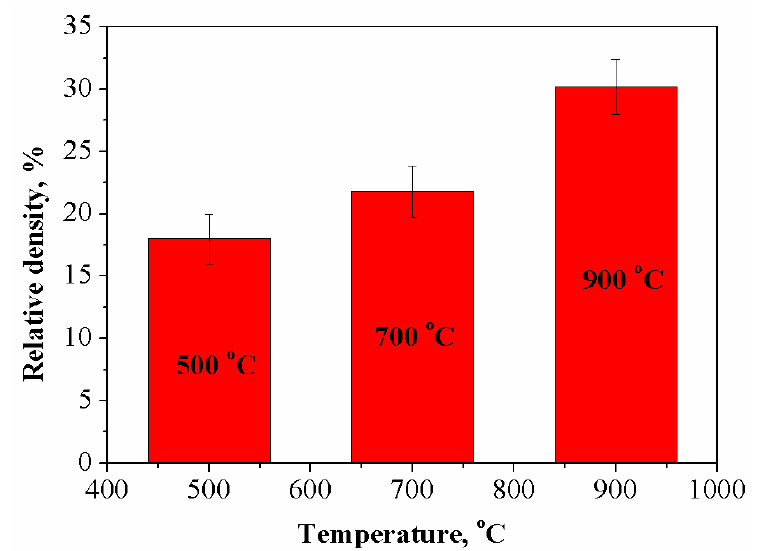
Figure 6. Shrinkage of ceramic samples, obtained by annealing of cement-salt stone in the tempera- ture range of 500–900 °C.